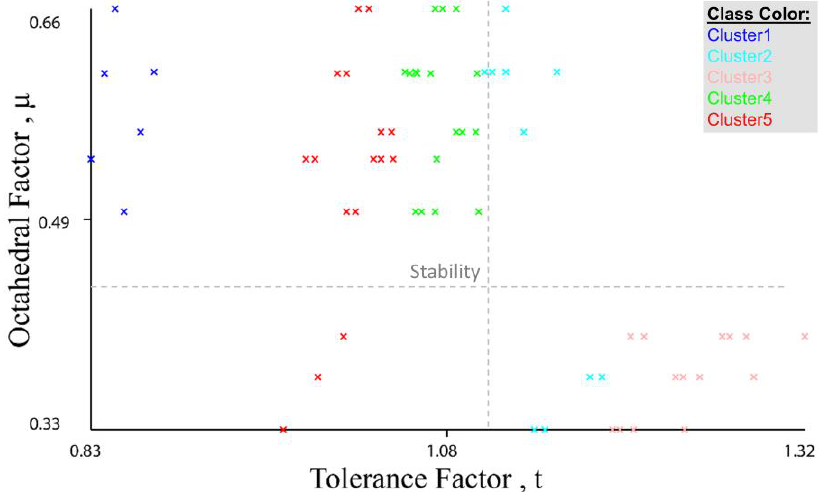
Figure 9. Octahedral factor vs. tolerance factor.